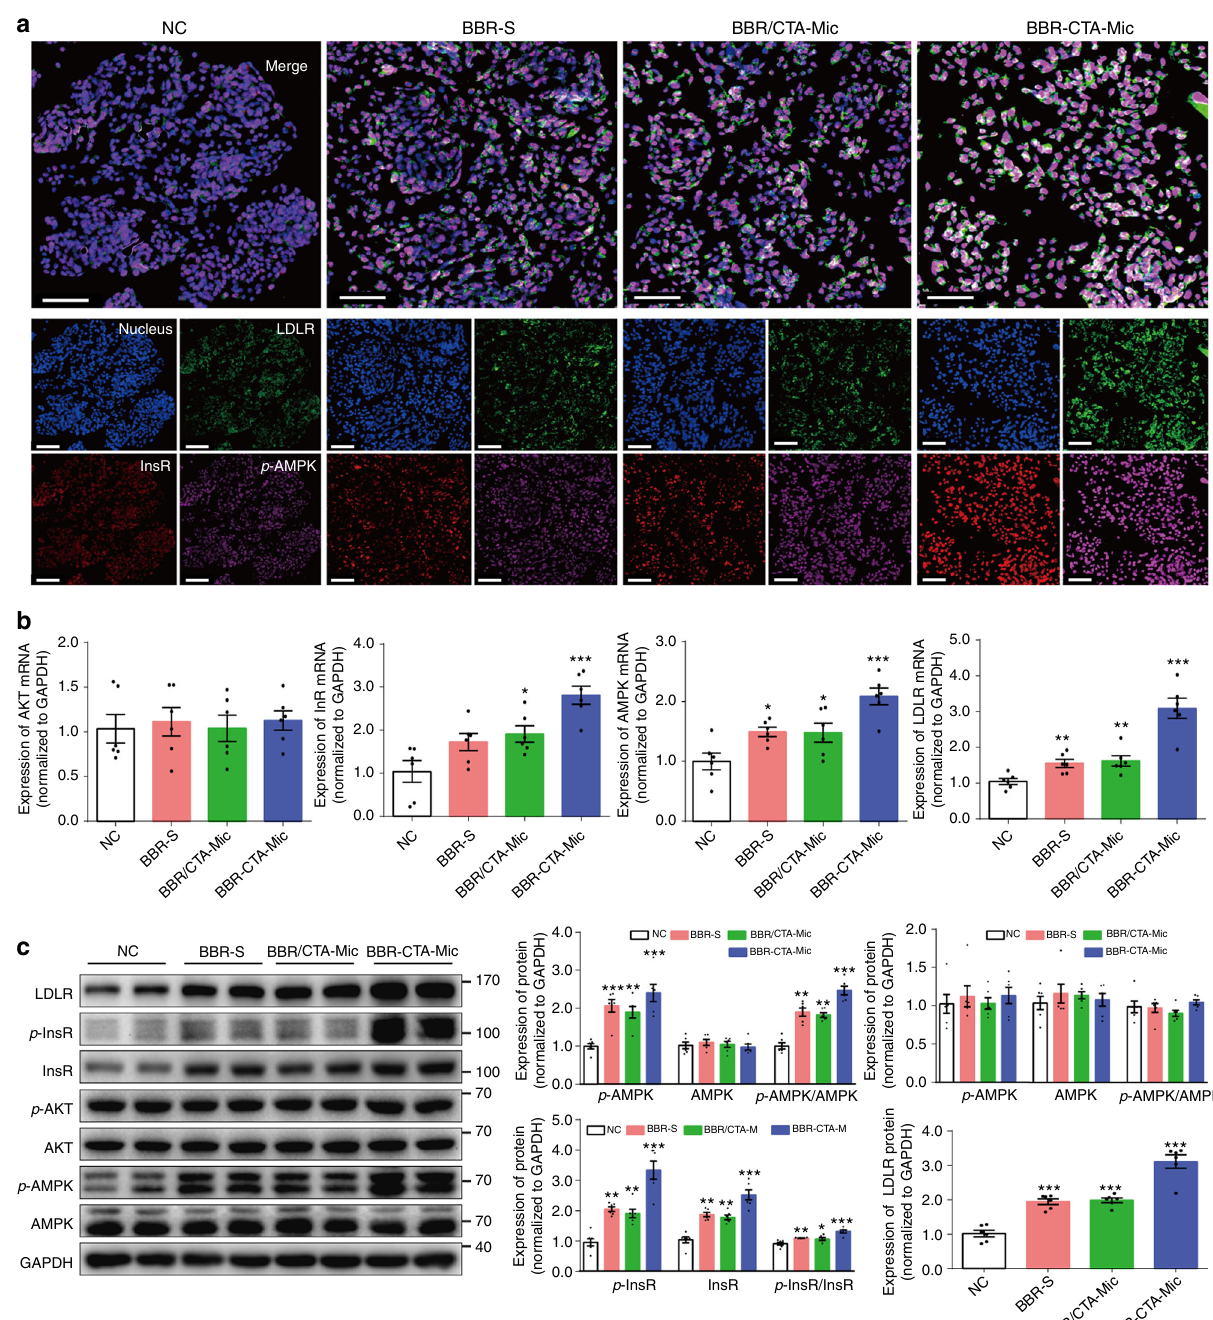
Fig. 4 In vitro pharmacological effect. The HepG2 cells were treated with various BBR formulations at an equivalent BBR concentration of 1 μ g mL − 1 for 8 h at 37 °C in 5% CO 2 . a The induction of p -AMPK (pink), InsR (red) and LDLR (green) protein expression by different BBR formulations was probed simultaneously with anti-InsR, LDLR and p -AMPK antibodies and visualized with C2t Nikon fl uorescent microscope (Morrell, USA). b The mRNA expression of AMPK , InsR , AKT , and LDLR genes was evaluated by RT-PCR. The results were normalized to GAPDH. c The protein expression of AMPK, p - AMPK, InsR, p -InsR, AKT, p -AKT, and LDLR was tested using western blot analysis. The results were normalized to GAPDH as density ratio. Data are presented as mean ± SEM ( n = 6), * p < 0.05, ** p < 0.01, *** p < 0.001, vs NC group, p- values were calculated by unpaired two-sided Student ’ s t -test. Scale bars, 100 μ m ( a )